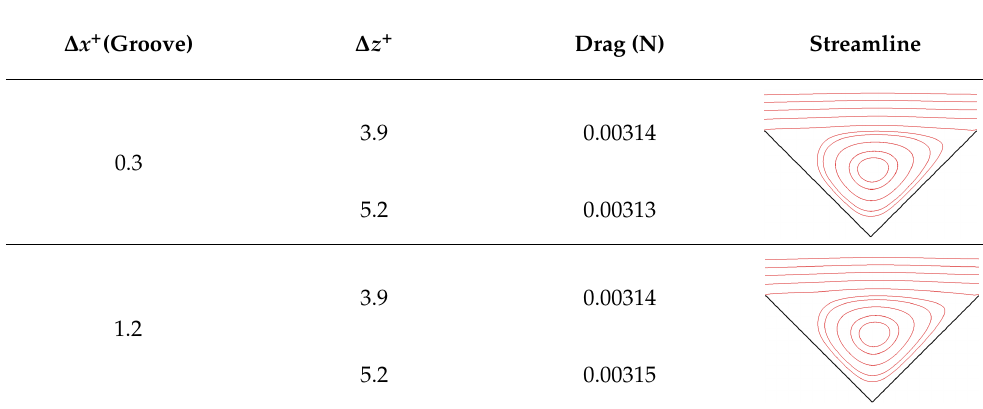
Table 2. Verification of grid resolution (h = 0.2 mm,